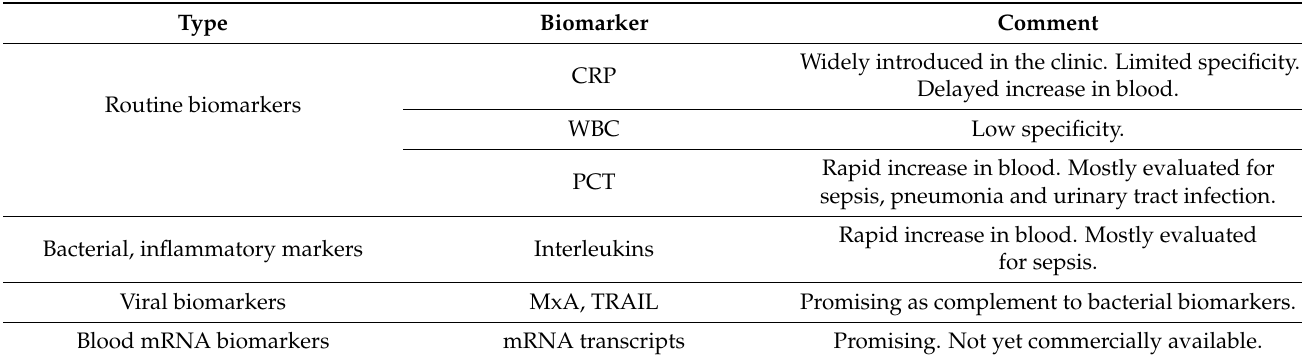
Table 1. Overview of biomarkers included in the